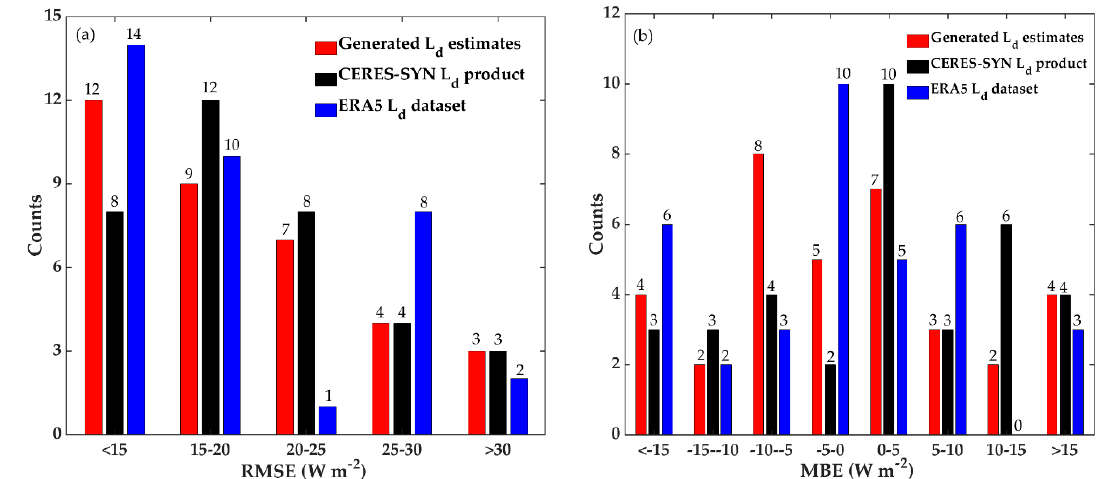
Figure 7. ( a ) RMSE and ( b ) MBE histograms of the daily L d estimates based on the GBRT model, CERES-SYN L d product, and ERA5 L d retrieval with a 100-km resolution against the ground measurements from March 2000 to December 2018.